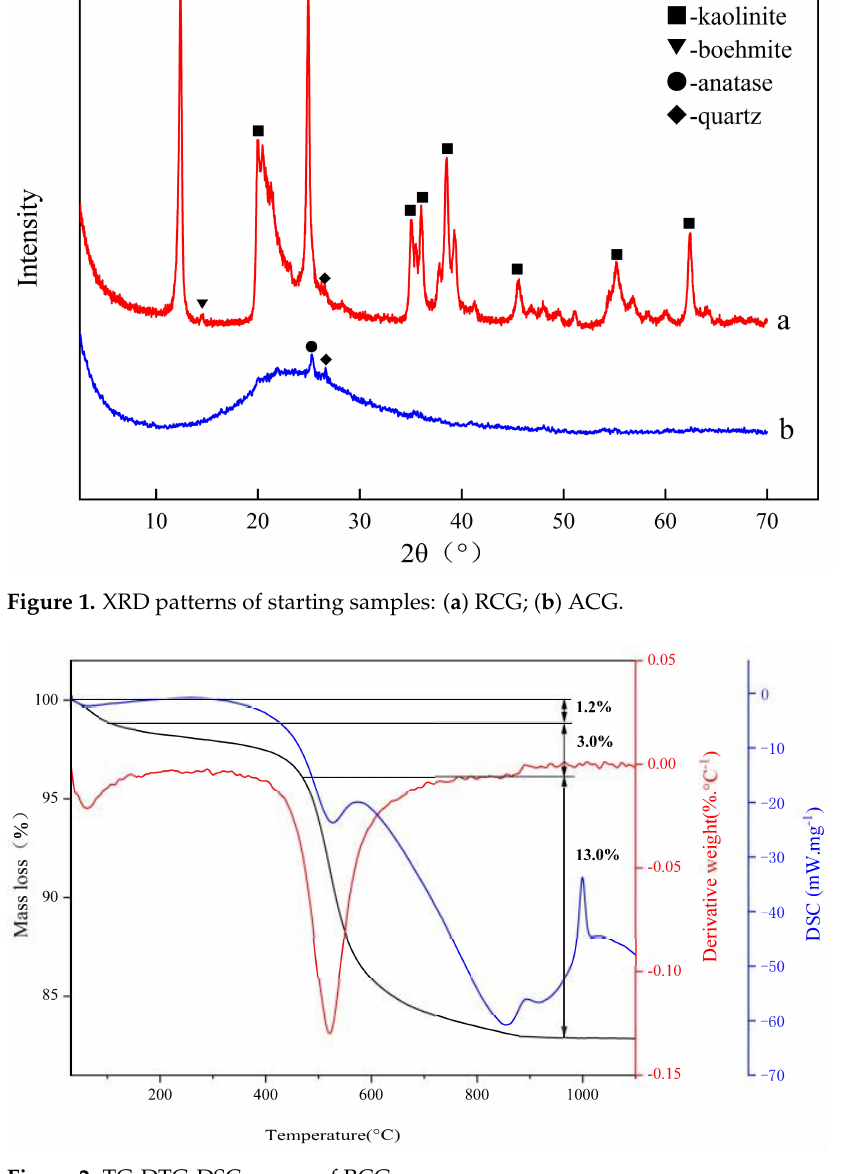
Figure 2. TG-DTG-DSC curves of